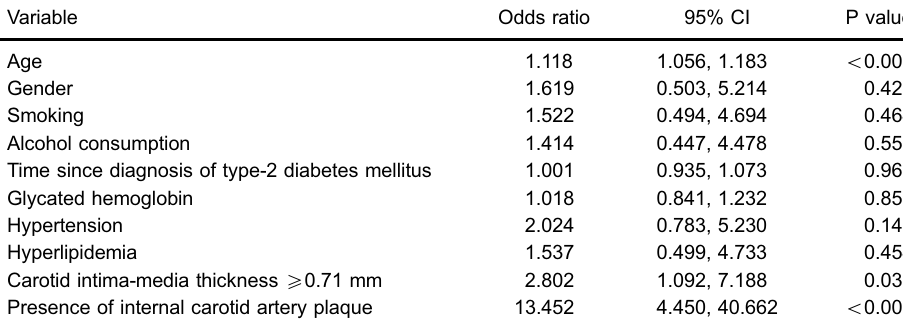
Table 3. Multivariate logistic regression analysis of factors associated with peripheral arterial disease.